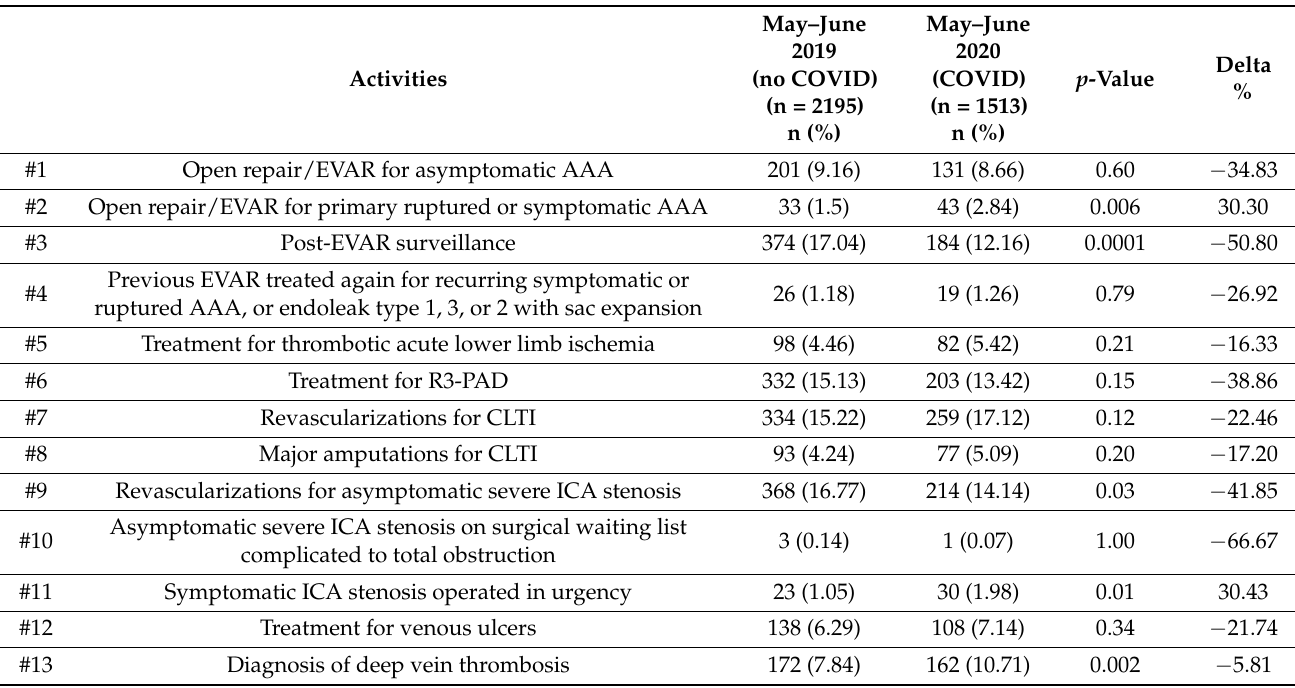
Table 4. Summary of the responses to the questionnaire for the COVID-19 months of May-June 2020 compared with the non-COVID-19 months of May-June